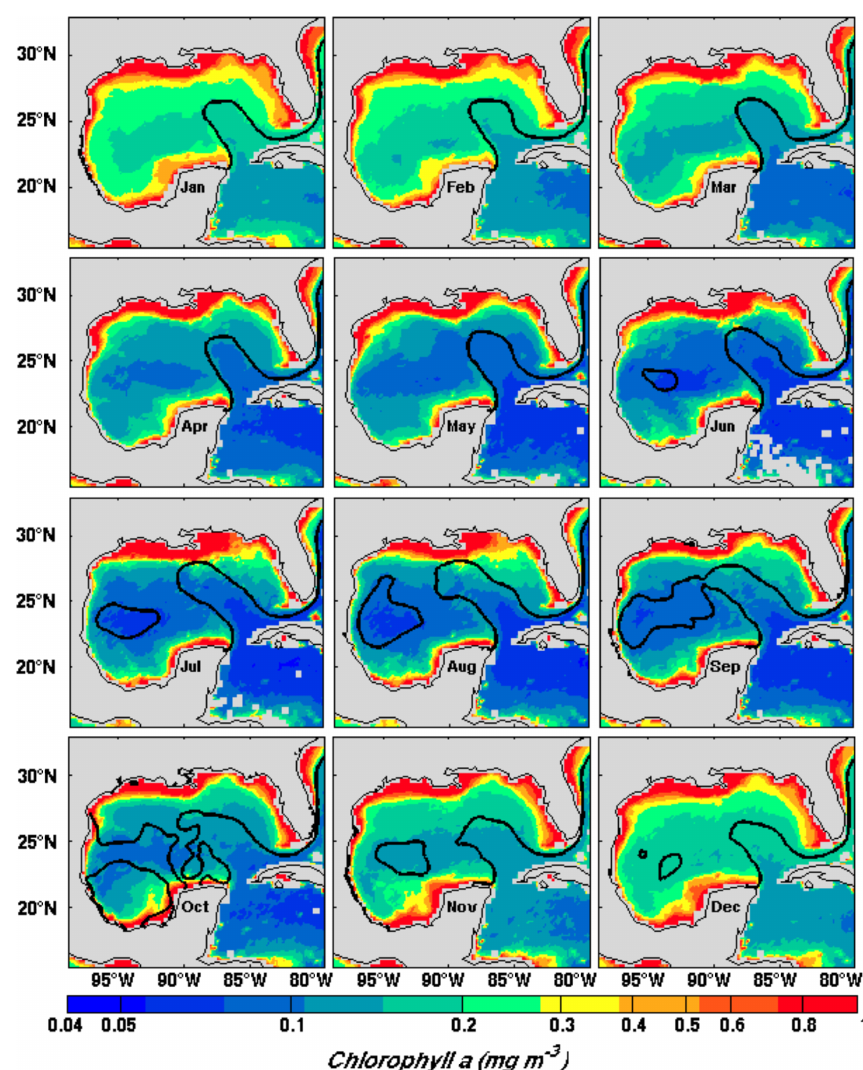
Figure 8. Monthly climatologies of Chl a (SeaWIFS 1998–2002 and MODIS data source 2003–2017). The heavy black line represents the contour of the 40cm ADT data that represents the CWF (1998–2017). Chl a values larger than 1mgm − 3 are plotted in